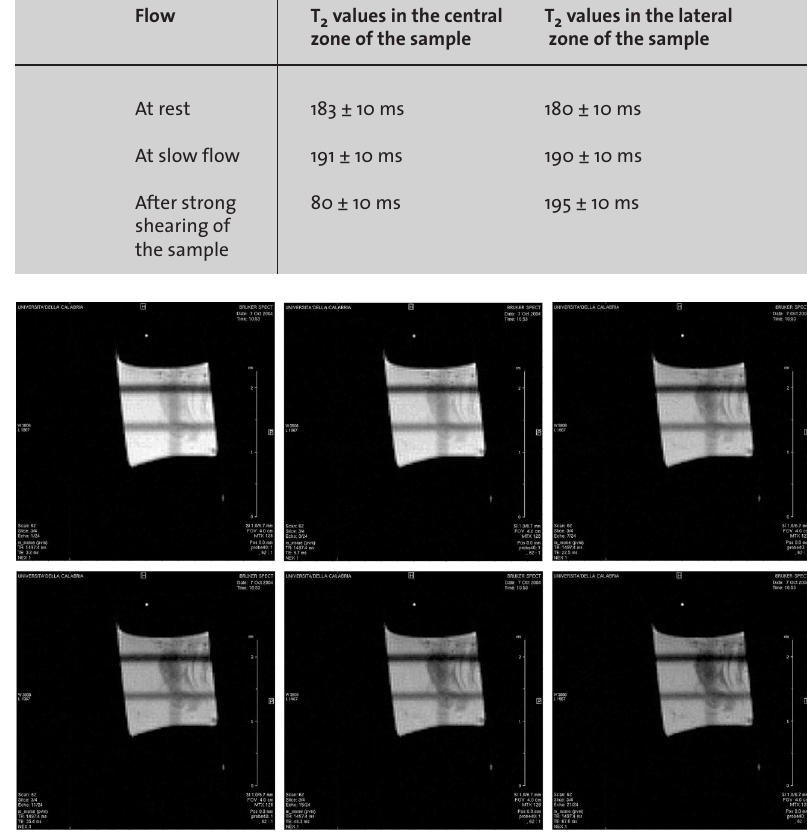
Table 1: Calculated T values for the 2 sample with f = 0.20 at dif- ferent flow intensity and in different zones. Figure 5: T weighted images for the 2 sample after strong shear- ing at